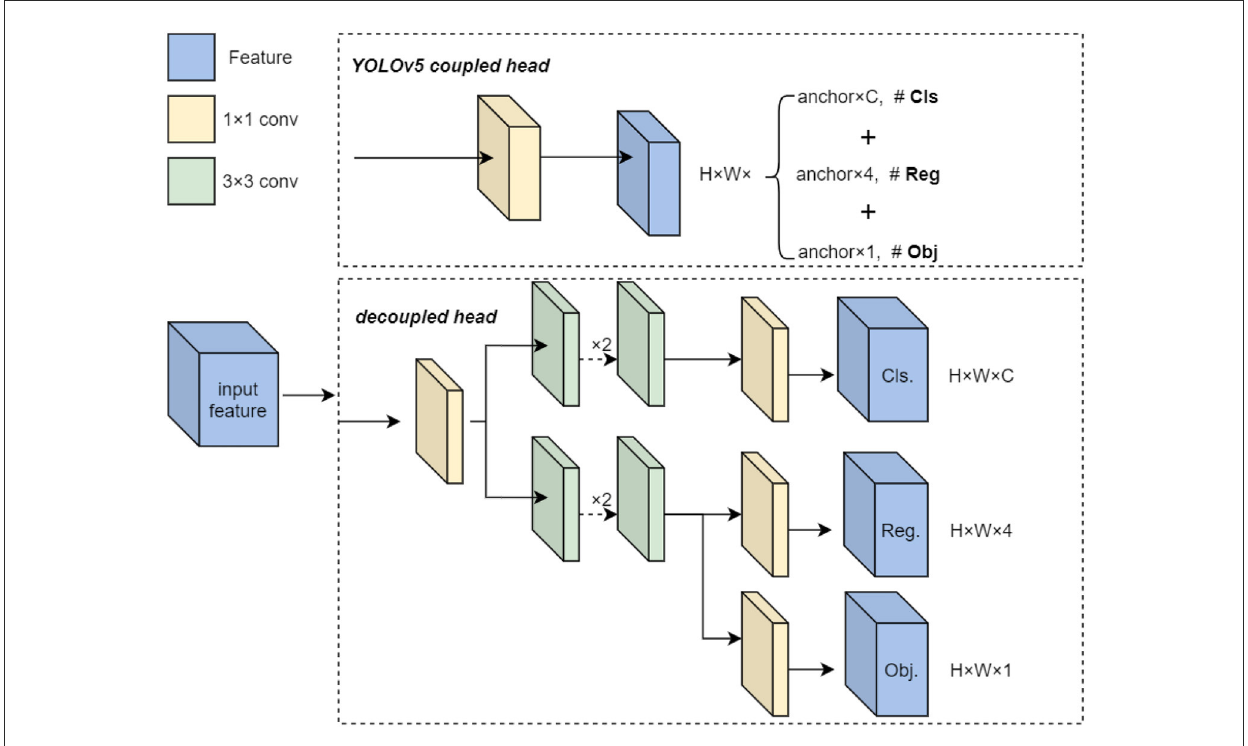
FIGURE3 The architecture of decoupled head.